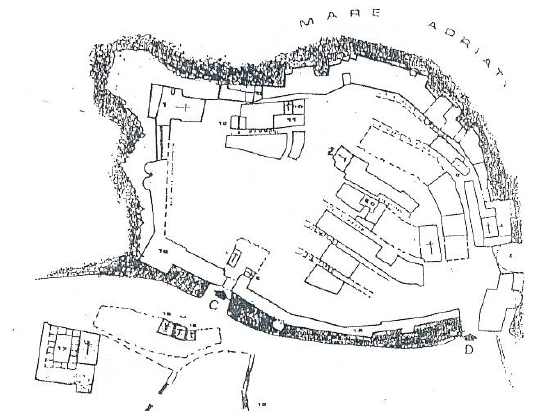
Figure 1. Development of historic district until medieval period. Source: Retrofit plan of historic district of Molfetta